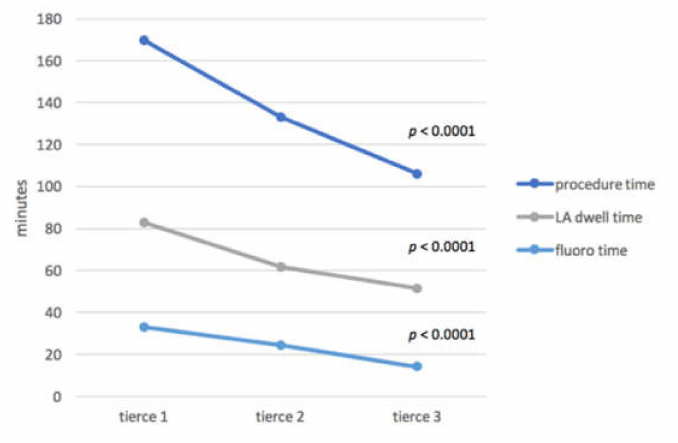
Figure 1. Procedure, left atrial (LA) dwell and fluoroscopy times in each tierce.